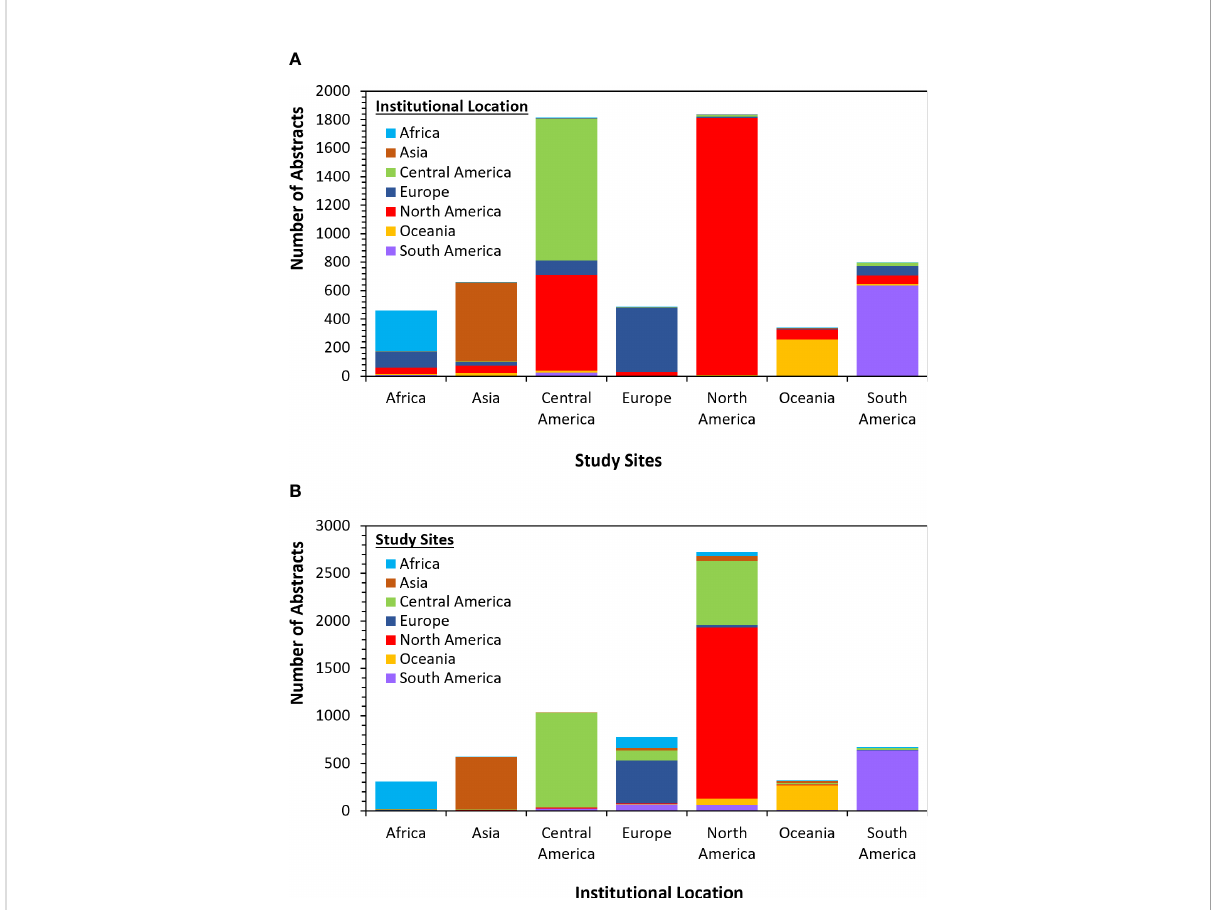
FIGURE 7 (A) The number of abstracts from study sites in each continent (x-axis). Each bar is divided into separate colors that represent the continent of the institutional site that conducted the research. (B) The number of abstracts from institutional sites in each continent (x-axis). Each bar is divided into separate colors that represent the continent of the study